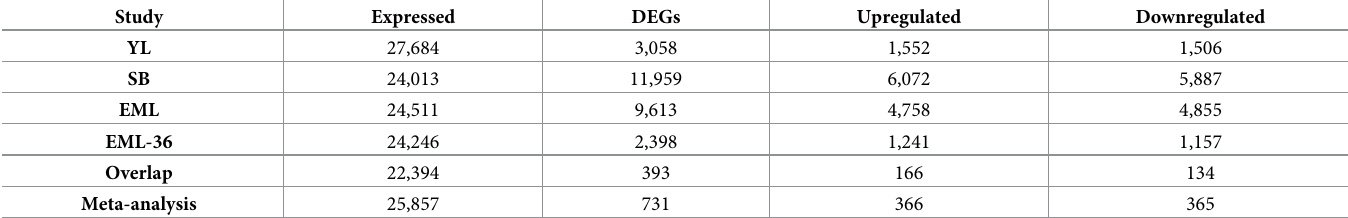
Table 1. Number of differentially expressed genes in different analyses. “Upregulated” and “downregulated” refers to the number of genes that are expressed at higher levels and lower levels respectively in symbiotic Aiptasia , relative to aposymbiotic